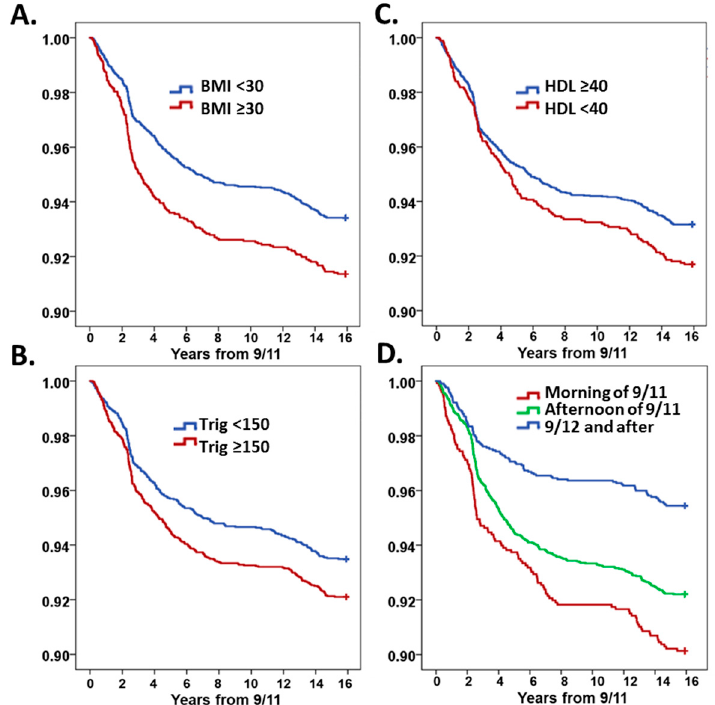
Figure 3. Kaplan–Meier survival curves stratified by ( A ). BMI ≥ 30 kg/m 2 ( p = 0.001 by log rank), ( B ). Triglycerides ≥ 150 mg/dL ( p = 0.019), ( C ). HDL <40 mg/dL ( p = 0.038), and ( D ). Exposure intensity ( p < 0.001). Cumulative disease-free survival is expressed on the y -axis and time in years from their WTC exposure is on the x -axis. Log rank was not significant for SBP, DBP, and glucose, and were not included in this graph.